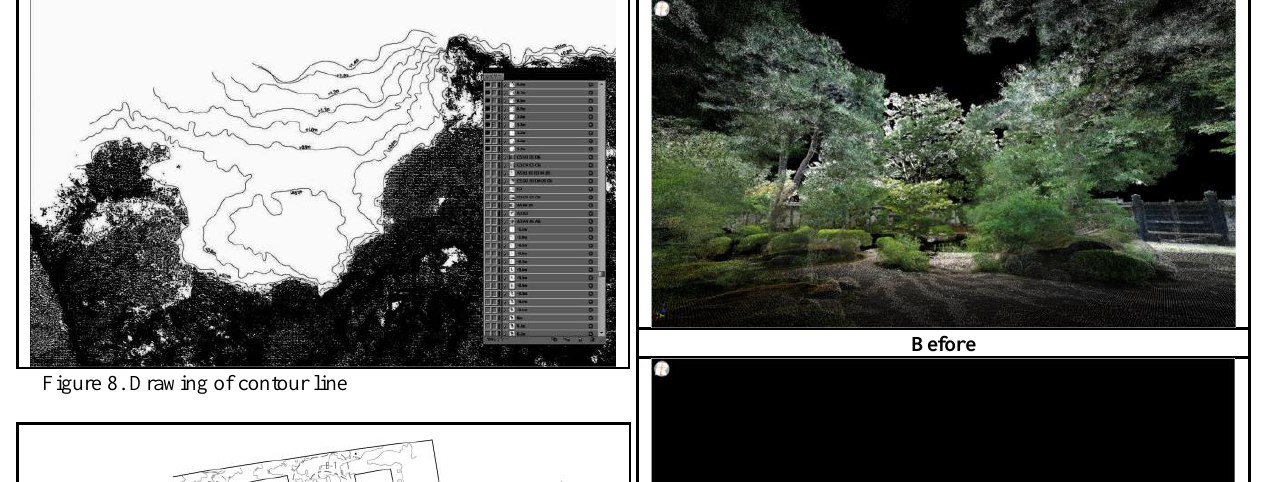
Before Figure 10. Landscape Simulation of Cutting Trees. (Saito Family Garden)